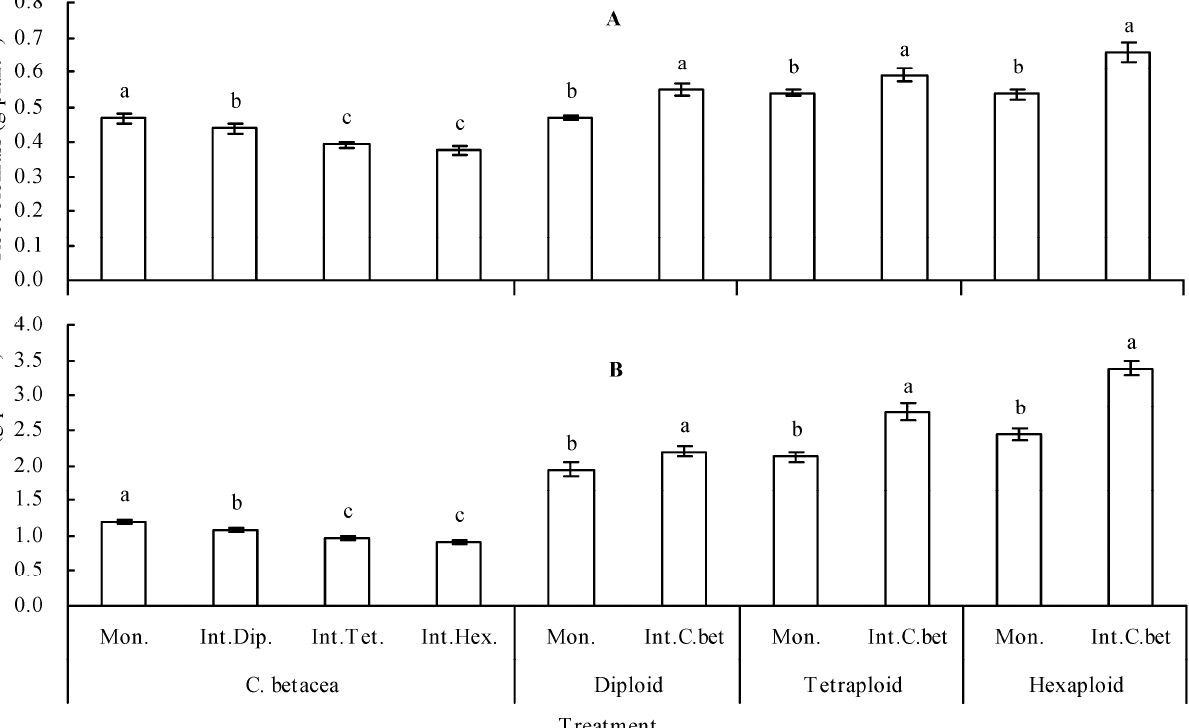
Figure 1. Biomass of plants. ( A ) Root biomass; ( B ) shoot biomass. Values are means ± SD of three replicates. Different lowercase letters indicate significant differences among the treatments (Dun- can’s multiple range test, p < 0.05). Mon. = monoculture; Int.Dip. = intercropped with diploid; Int.Tet. = intercropped with tetraploid; Int.Hex. = intercropped with hexaploid; Int.C.bet = intercropped with C. betacea .